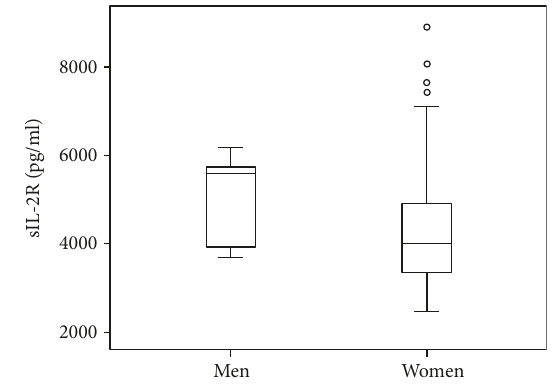
Figure 2: Boxplot of the sIL-2R level by gender in CRPS